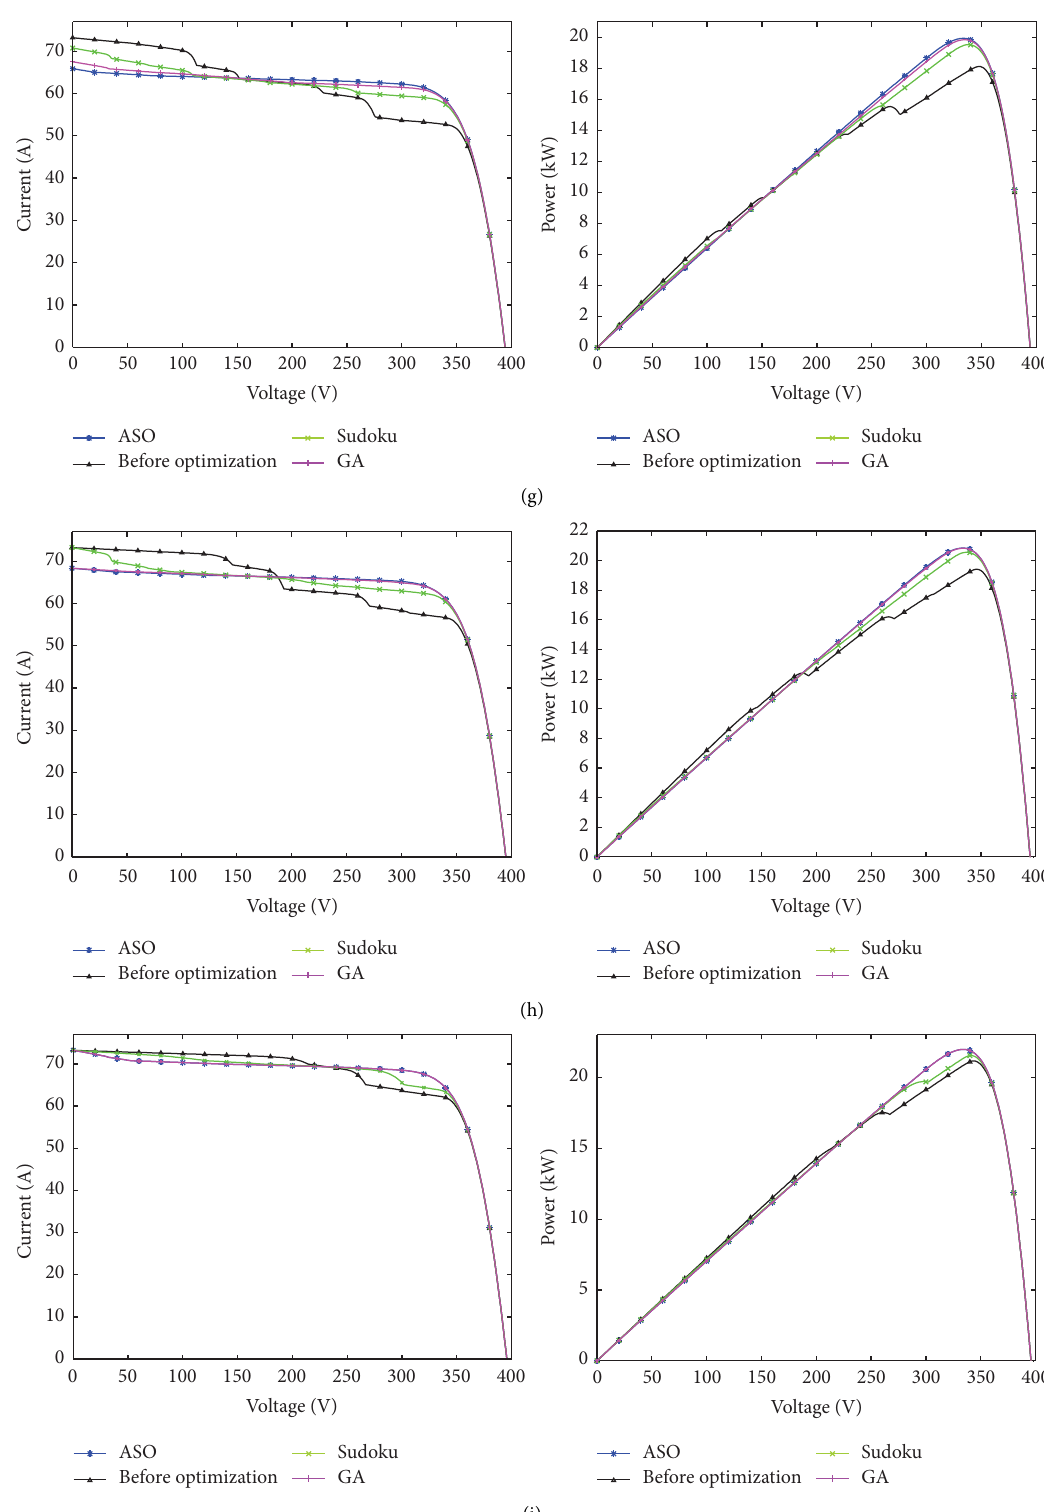
Figure 7: I - U and P - U curves of PV arrays with the PSC of moving clouds in 9minutes: (a) 1min; (b) 2min; (c) 3min; (d) 4 min; (e) 5min; (f) 6 min; (g) 7min; (h) 8min; (i)